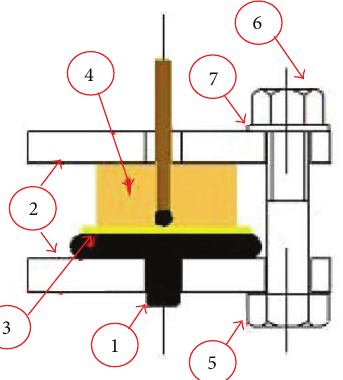
Figure 9: Test cell electrode system: (1) plane electrode; (2) acrylic plate; (3) kapton spacer; (4)Molded sphereelectrode with specimen; (5) polycarbonate bolt; (6) polycarbonate nut; and (7) nylon washer [26].